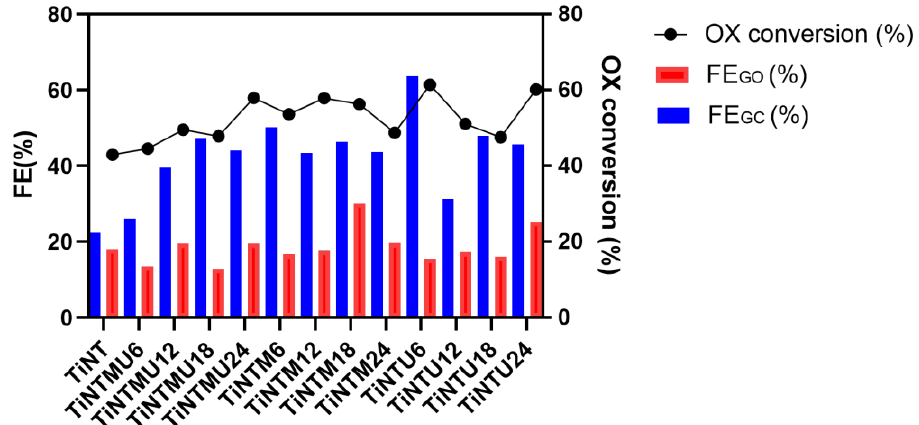
Figure 9. Efficiency to glyoxylic and glycolic acid of g-C 3 N 4 /TiO 2 composites and TiNT reference sample at the potential of − 1.2 V vs. Ag/AgCl after 2 h of reaction.